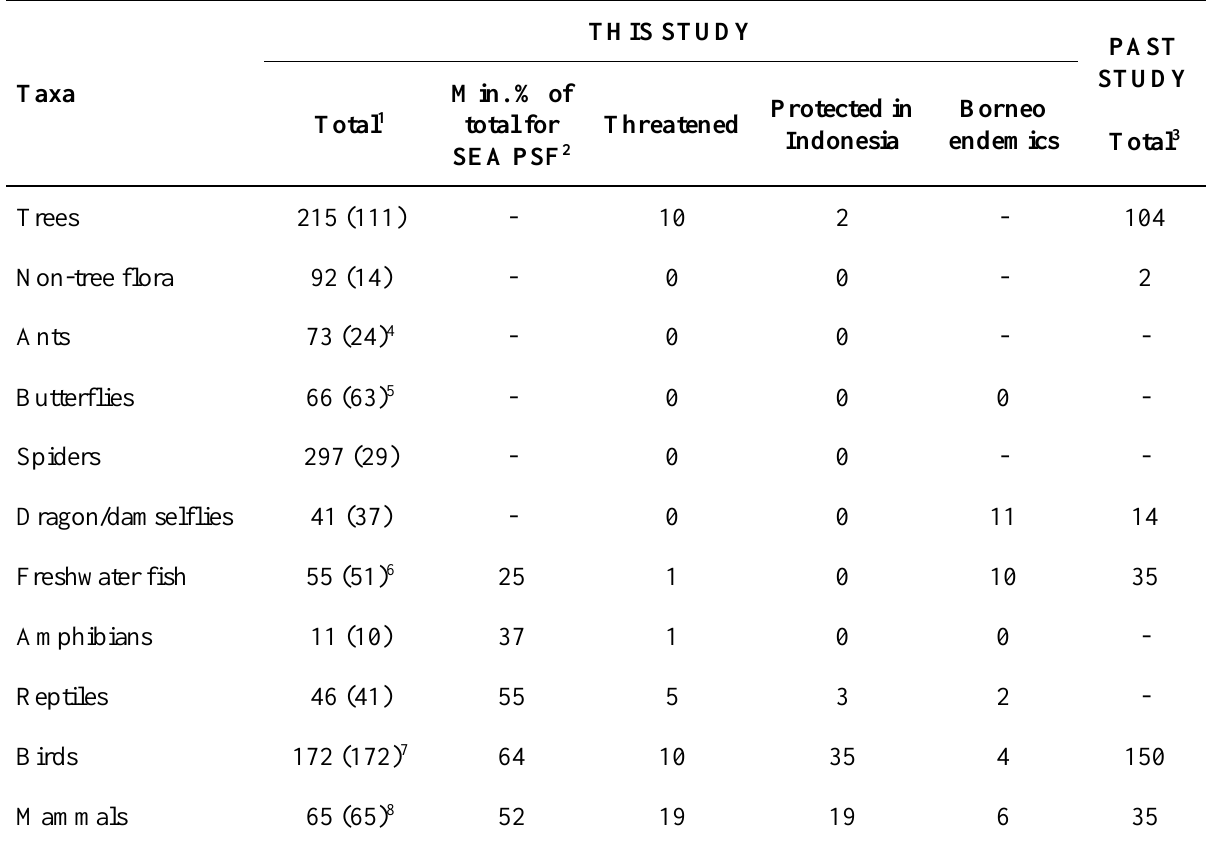
Table 1. Summary of total number of species recorded in the NLPSF, Sebangau by taxonomic group and comparison to previous published data for the area. “Threatened” species are those considered Vulnerable (VU), Endangered (EN) or Critically Endangered (CR) by the